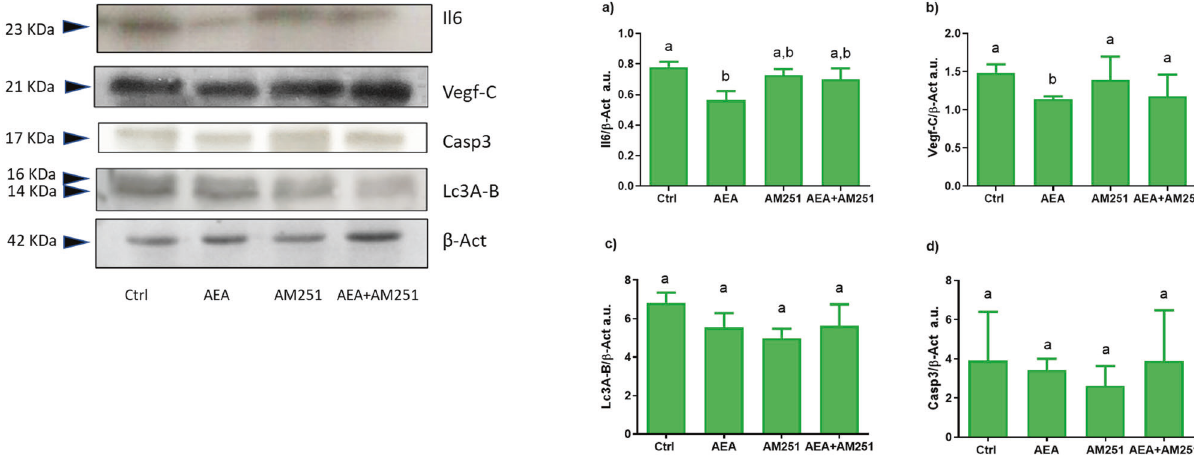
Fig. 5 AEA effects on molecular targets involved in angiogenesis and in fl ammation. Insets show a representative Il6, Vegf-C, Casp3, Lc3A/B, and β -Act Western Blot in the different experimental groups. Densitometric analysis of three independent experiments, a.u. (arbitrary units) a Il6, b Vegf-C, c Lc3A/B, d Casp3. Different letters above each column indicate statistical differences among groups (one-way ANOVA, P <